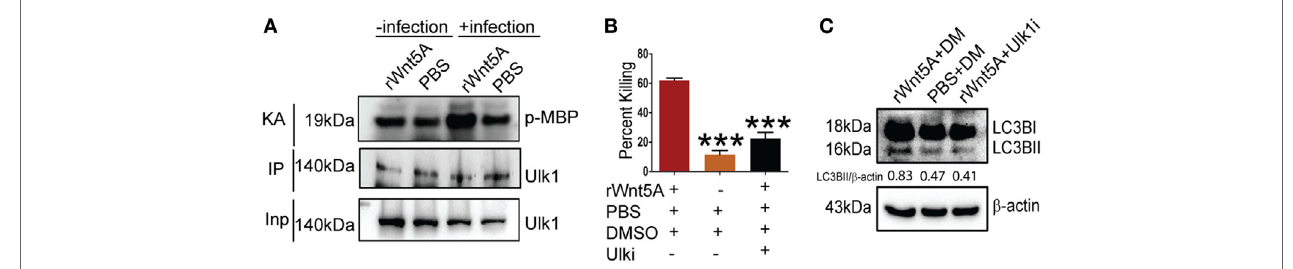
FigUre 6 | Ulk1 kinase activity (KA) is needed for rWnt5A-mediated bacterial clearance. (a) At 2 h killing time point (T2), immunoprecipitated (IP) Ulk1 from rWnt5A-treated RAW 264.7 cells demonstrates greater Ulk1 KA than the corresponding control as judged by phosphorylation of myelin basic protein (MBP). Significant difference in KA not noted in uninfected cells pretreated with Wnt5A or PBS ( n = 3). Inp (Input) is same in all cases. (B) rWnt5A-mediated killing inhibited by Ulk1 kinase inhibitor (Ulk1i) at 3 h (T3) killing time-point ( n = 3). DM (DMSO) and PBS were used as vehicle control. (c) rWnt5A-mediated LC3BII accumulation inhibited in presence of Ulk1i ( n = 3). Data represented as mean ± SEM; *** p ≤